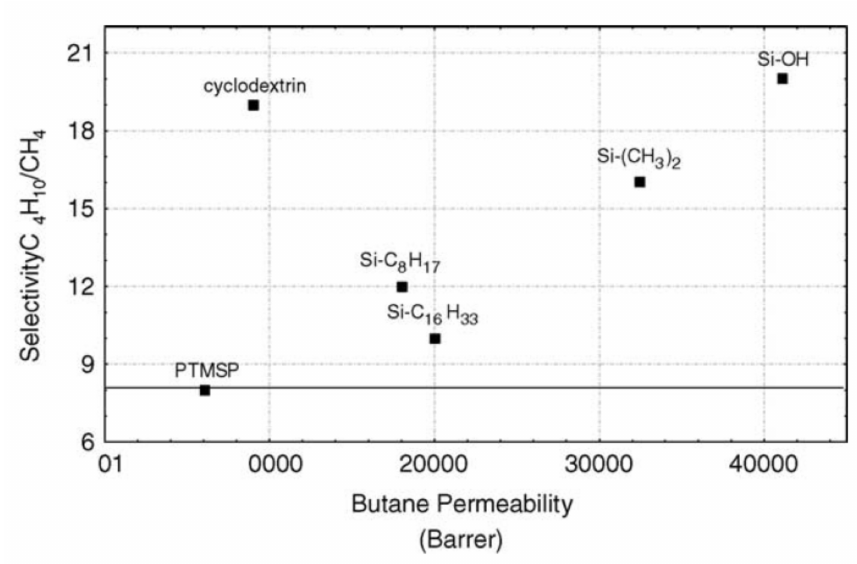
Figure 14. Permeation properties for mixture gas in PTMSP nanocomposite membrane prepared by adding 30 wt. % filler (based on polymer content) at 30 ◦ C with feed pressure of 1.4 bar and permeate pressure of 1 bar (used with copyright permission)